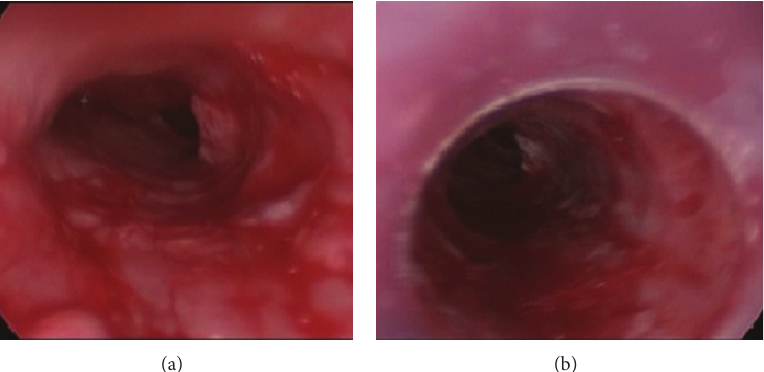
Figure 2: Severely inflamed mucosa with bleeding to touch (a). After insertion of Montgomery T-tube, second procedure (b).